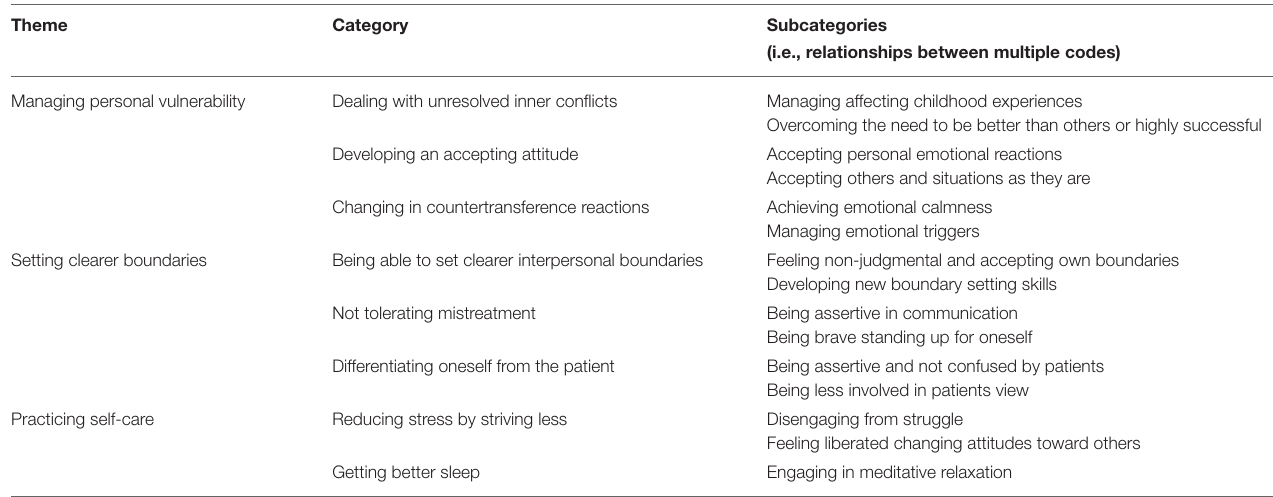
TABLE 2 | An overview of themes, categories, and subcategories.